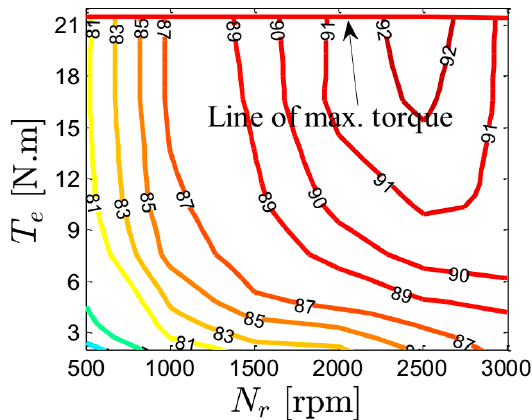
Figure 30. Measured efficiency map of the whole drive system using the Sd-PM machine at optimal